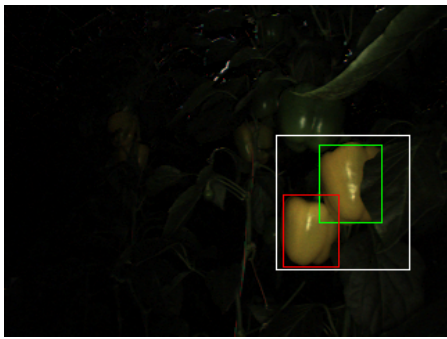
Figure 8. Example of a clustered detection: the detected area ( white ) overlaps both a pepper considered to be a true positive detection ( green ) as well as one considered a false negative detection ( red